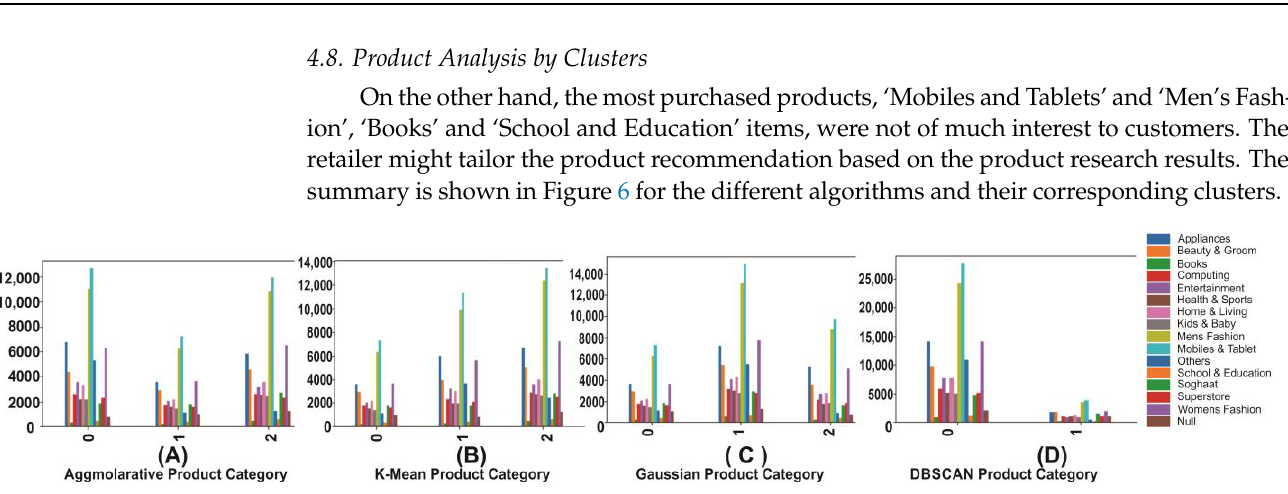
Figure 6. Product category distribution on 3 or 2 clusters using different algorithms.